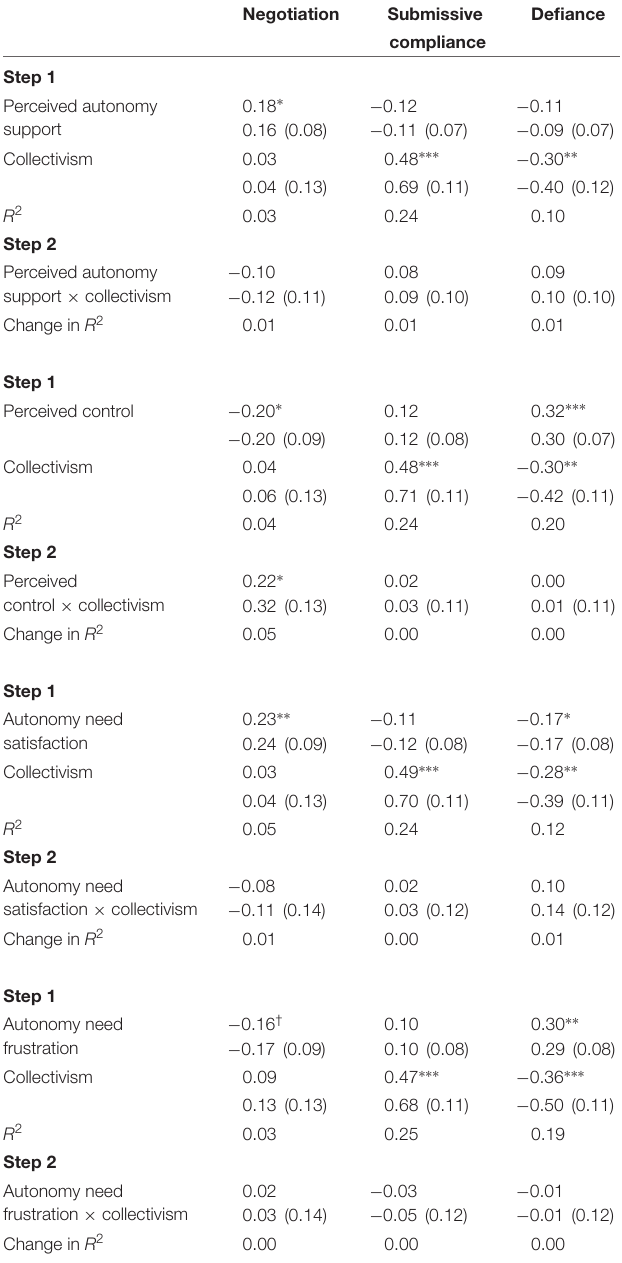
TABLE 4 | Interactions between collectivism and appraisals in the prediction of responses to parental behavior (the first coefficients shown are standardized regression coefficients – the second coefficients shown are unstandardized coefficients – with standard errors between